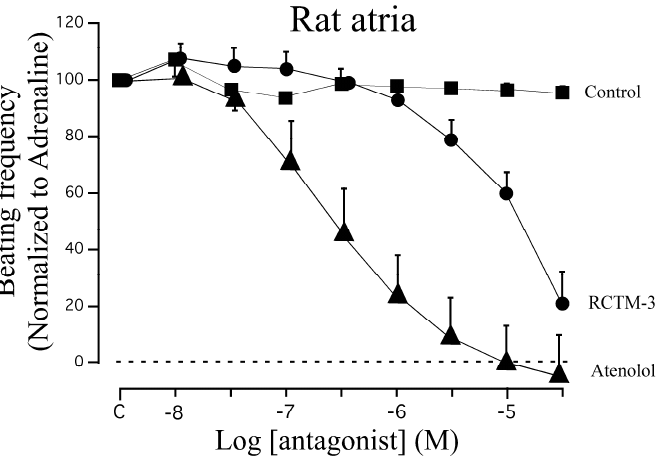
Figure 3. Inhibitory effects of RCTM-3 on isolated rat atria. Once stabilized, the preparations were stimulated with adrenaline (300 nM) and the frequency of beating was measured and normalized to 100%. Cumulative concentrations of no drug (control), RCTM-3 or atenolol were added to the organ bath. Data show the means ± SEM from 8–10 different